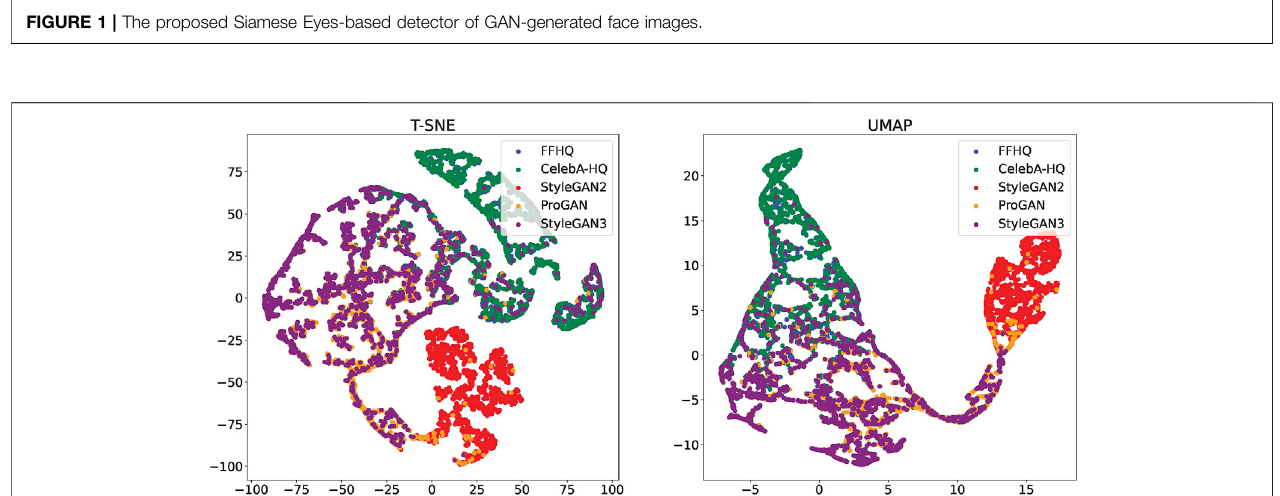
FIGURE 2 | Feature space distribution for each dataset using T-SNE and UMAP reduction methods. 2,000 images per each dataset have been considered.